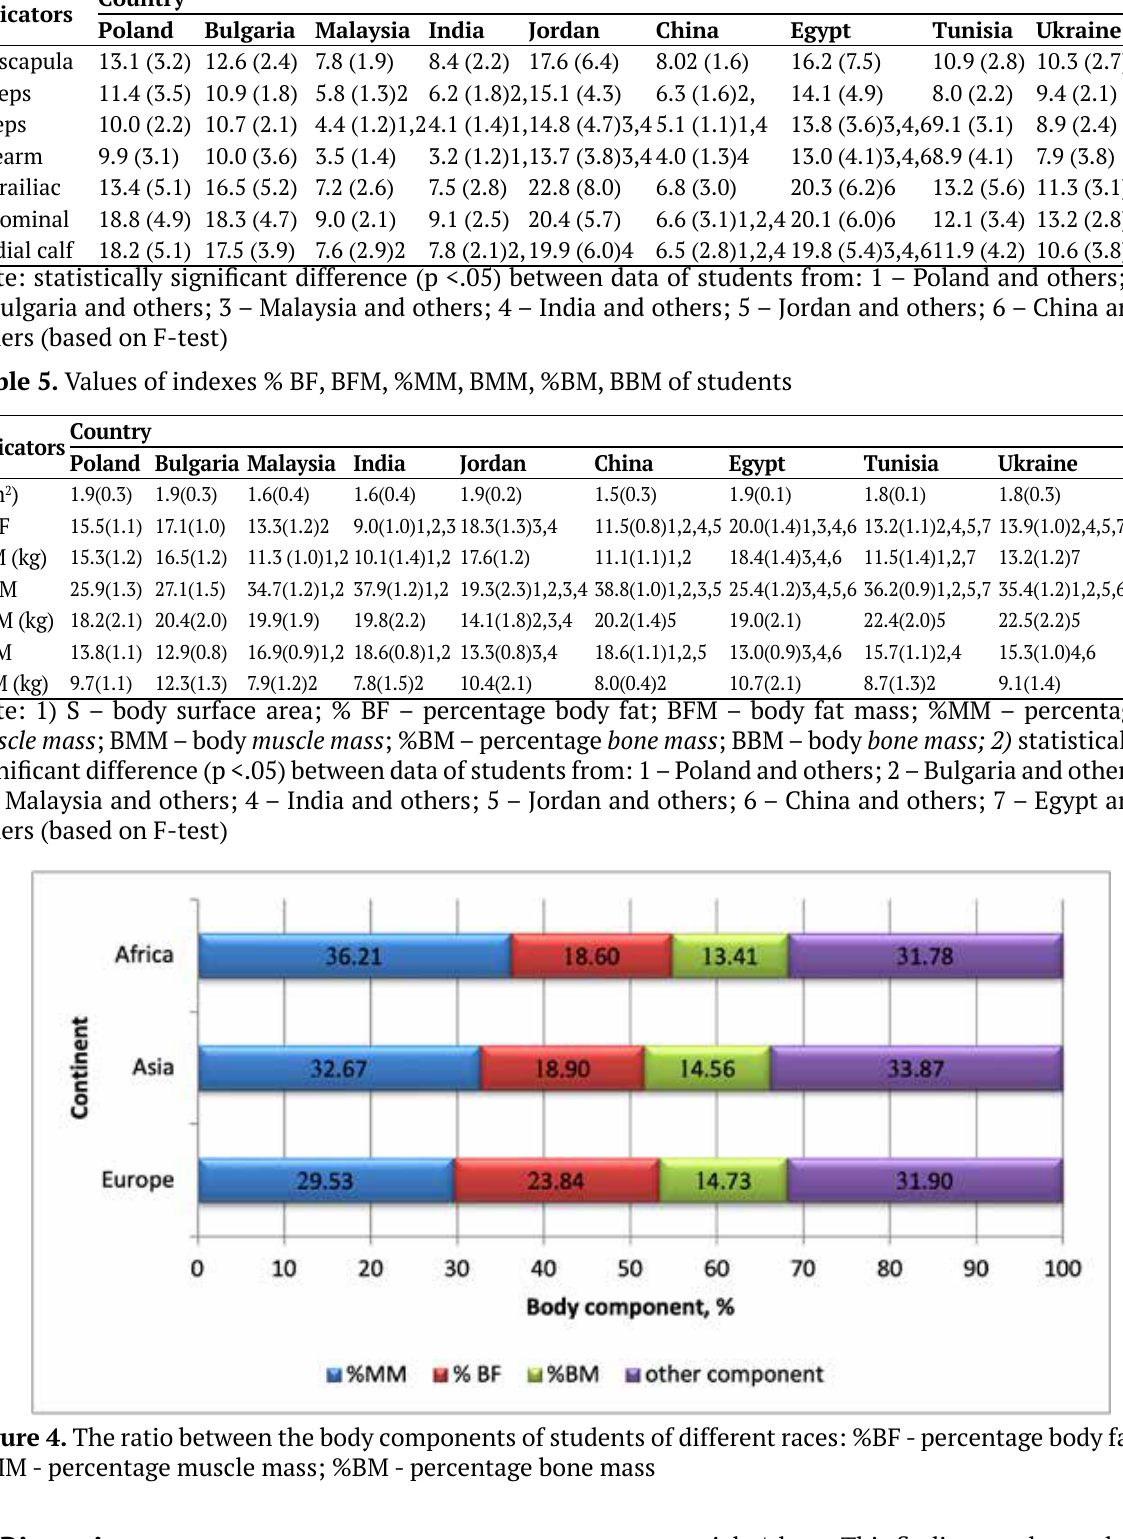
Table 4. Thickness of fat folds of students, X̄ (SE) Indicators